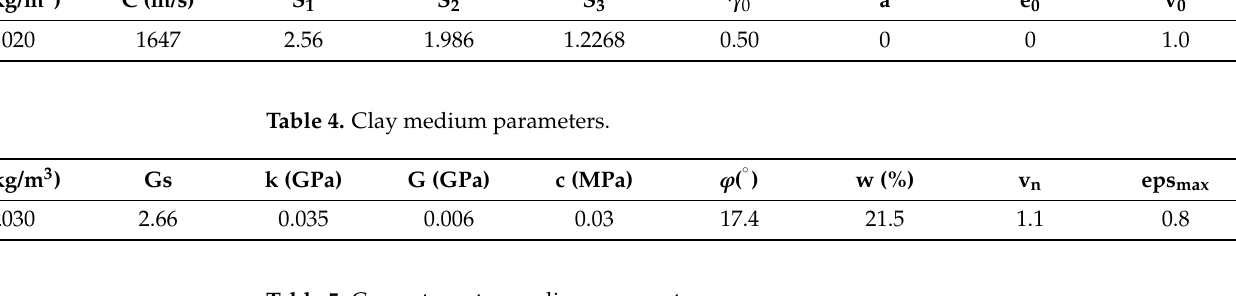
Table 5. Cement mortar medium parameters.